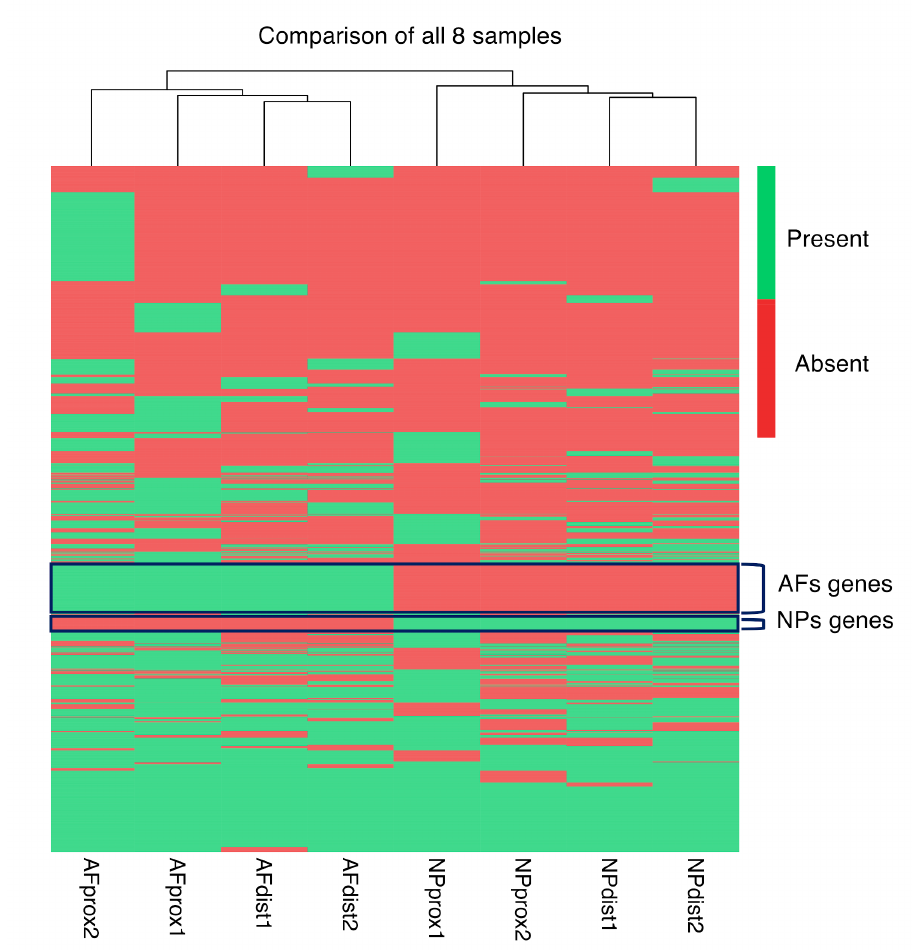
Figure 7. Heat map scRNAseq. Heat map depicting the presence and absence of expressed genes (top cluster markers) in the proximal and distal AFs and NPs of Animals 1 and 2, scRNAseq data. The gene clusters that are expressed exclusively in AFs and NPs are of particular interest as potential